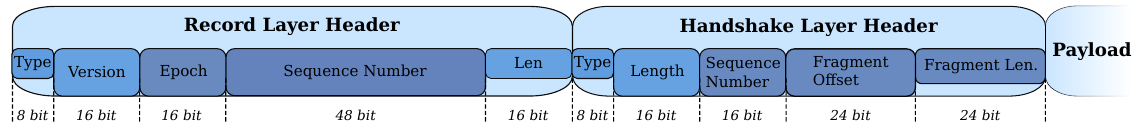
Figure 3. Illustration of the DTLS headers for a handshake message. In the record layer header, DTLS adds the epoch and sequence number fields. In the handshake header, DTLS adds sequence numbers, a fragment offset, and fragment